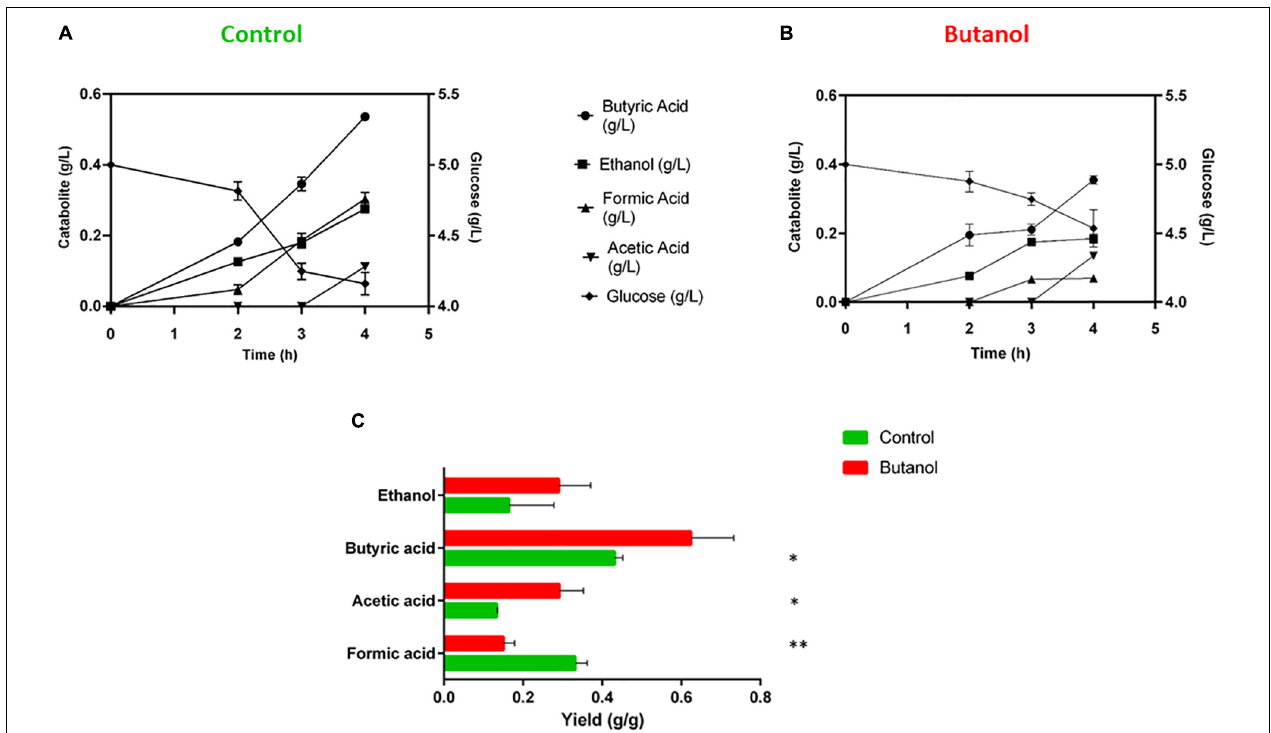
FIGURE 2 | Glucose consumption and catabolite production of C. cellulovorans grown in control condition (no added butanol, A ) or in butanol-supplemented medium (B) . (C) Fermentation end-product yield (g per g of consumed glucose). Data are the mean of triplicate measurements. Bars represent standard errors. Asterisks indicate values that significantly ( ∗ p -value < 0.05; ∗∗ p -value < 0.01) differ between control (green) and butanol-supplemented (red) culture conditions.